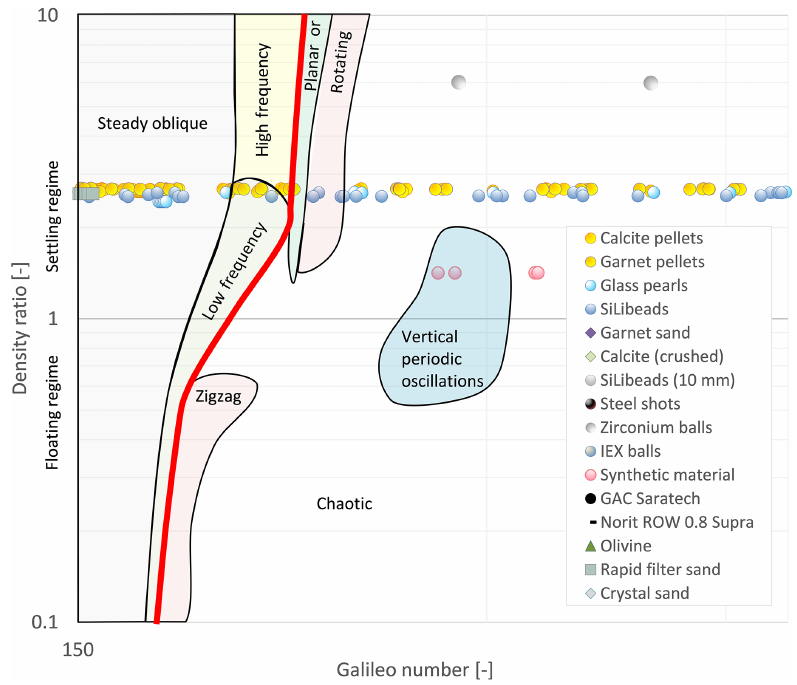
Figure 10. Path trajectory regime plot according Zhou and Dušek (2015) and Raaghav (2019; magnified area of Fig. 9). The chaotic regime applies to the right of the red